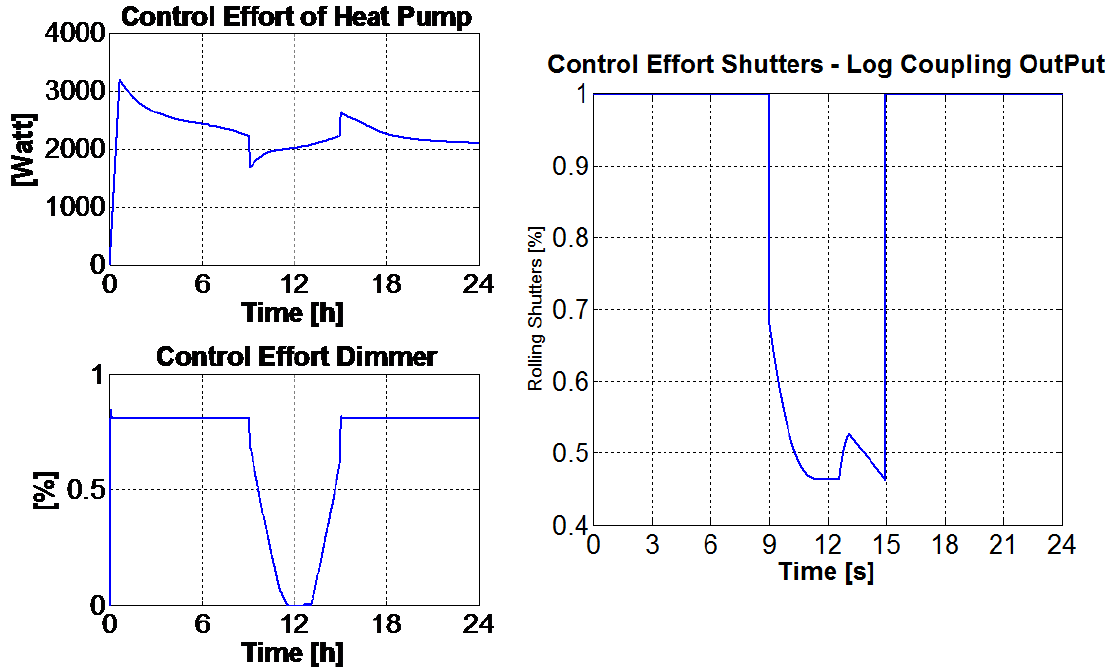
Figure 29. Control results (first scenario, initial control system, Comfort policy): MVs (heat pump, dimmer, and rolling shutters).